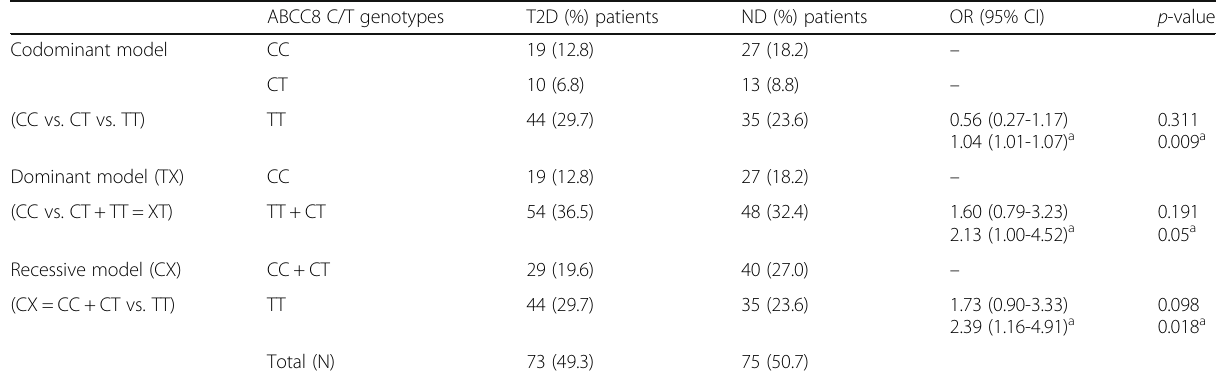
Table 2 Association of ABCC8 C/T genotypes in participants based on risk models ABCC8 C/T